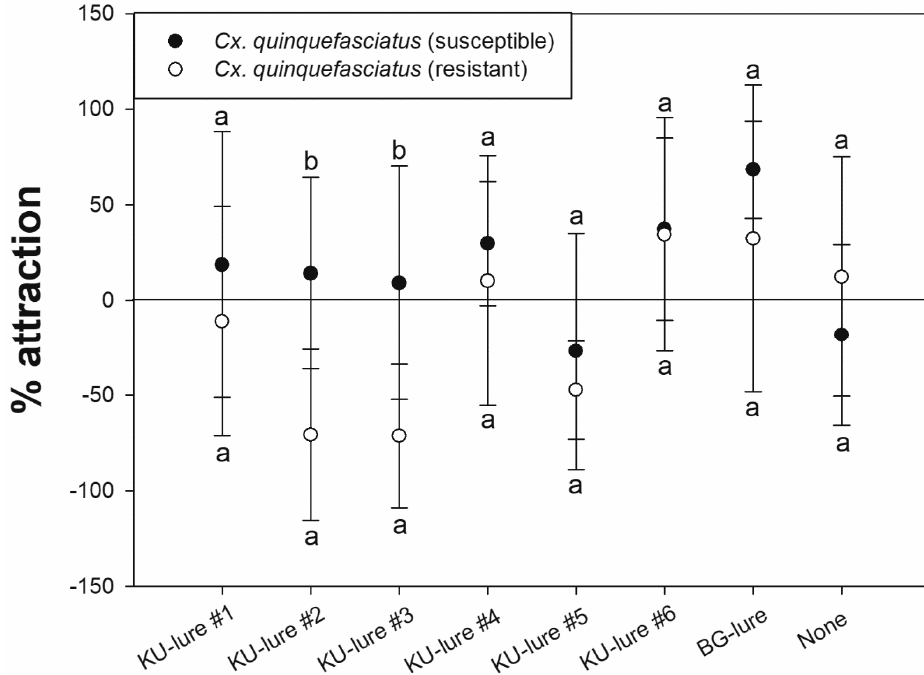
Figure 3. Percent attraction to KU-lures (0.01 g) and the BG-lure positive control (0.05 g) as determined by HITSS assay. Results were compared between pyrethroid-susceptible and -resistant strains of Culex quinquefasciatus . A positive value indicates attraction to the treated chamber, while a negative value indicates repulsion from the treated chamber (more mosquitoes in the untreated chamber). For all lures, except KU-lures #2 and #3, the Mann–Whitney U test showed no significant difference between mosquito strains ( p < 0.05).